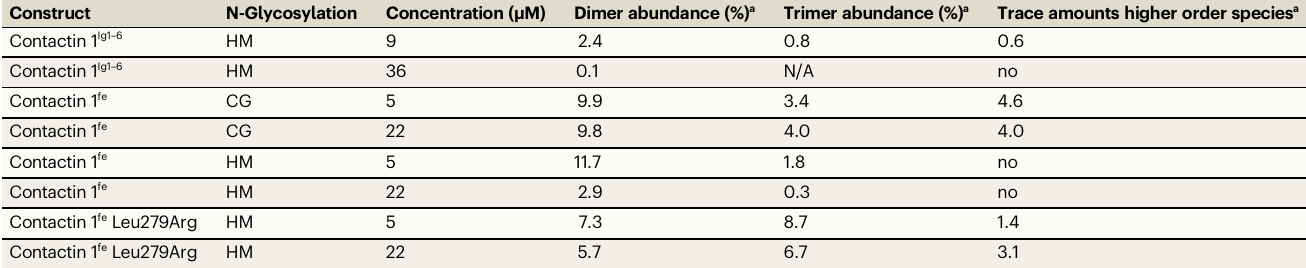
Table 2 | SV-AUC relative abundance of oligomer species Construct